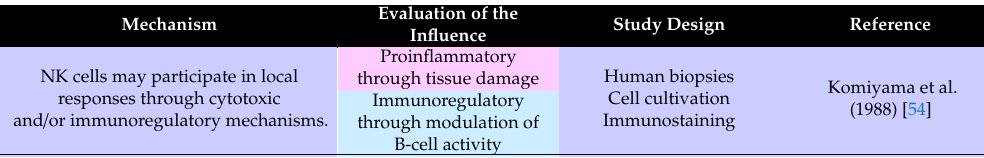
Table 1. NK cell-mediated mechanisms in periodontitis. NK cell, natural killer cell; DC–dendritic cell;